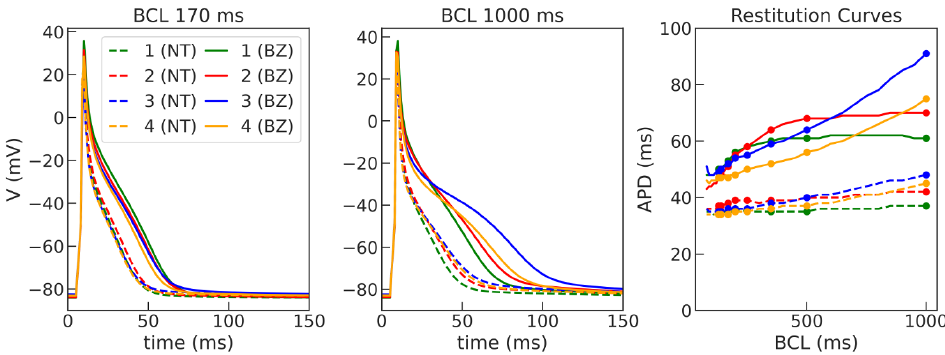
Figure 4. Action potential signals at 170 and 1000 ms BCL (left and middle panels, respectively) and APD restitution curves (right panel) in Models 1–4 for normal tissue (NT, dash lines) and the border zone (BZ, solid